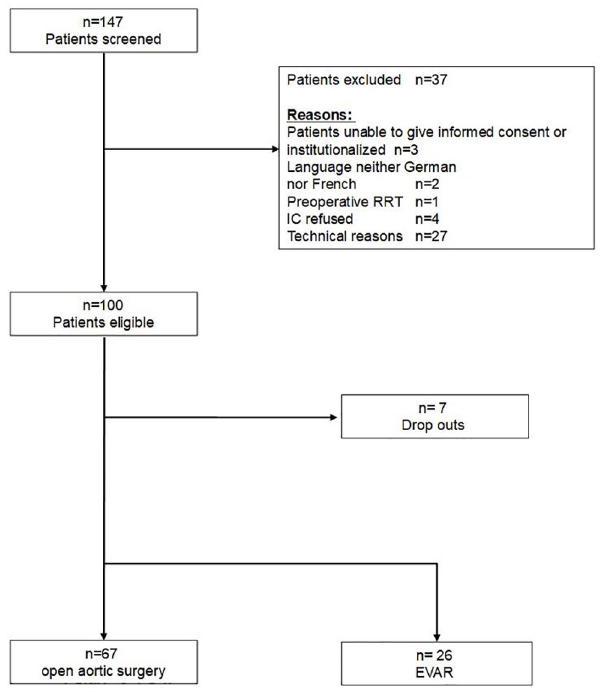
Fig 1. Patient flow chart. RRT Renal Replacement Therapy; IC informed consent; EVAR endovascular aortic repair.